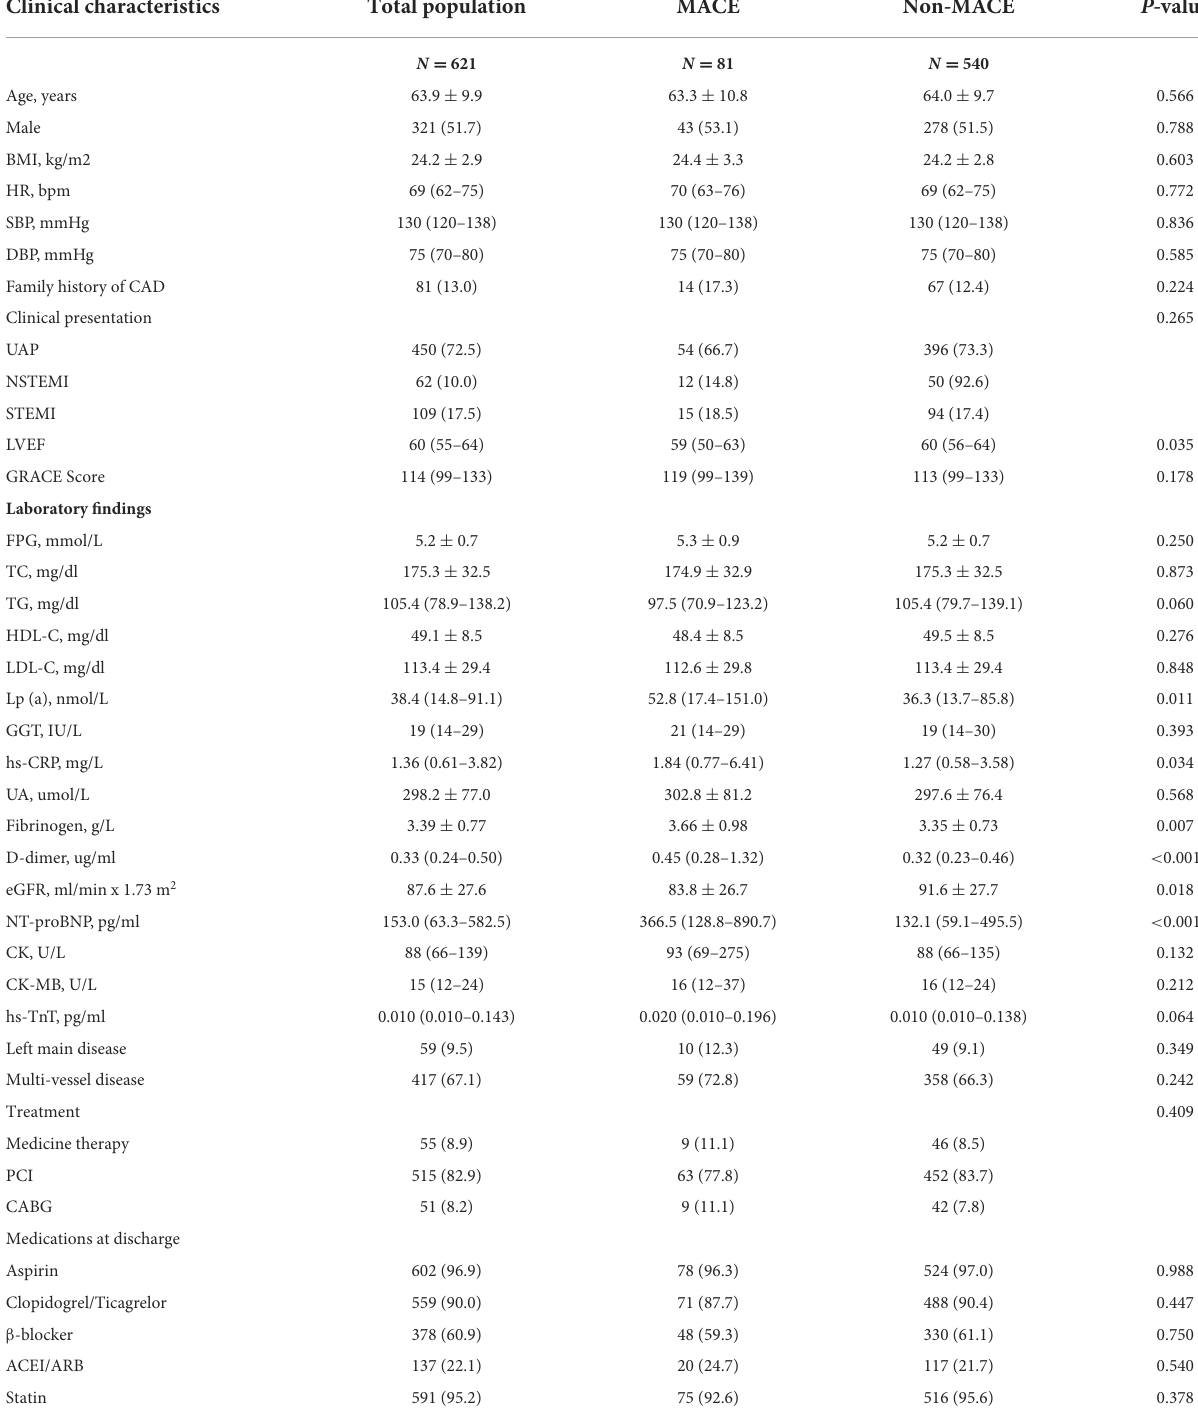
TABLE 1 Baseline characteristics of patients with and without